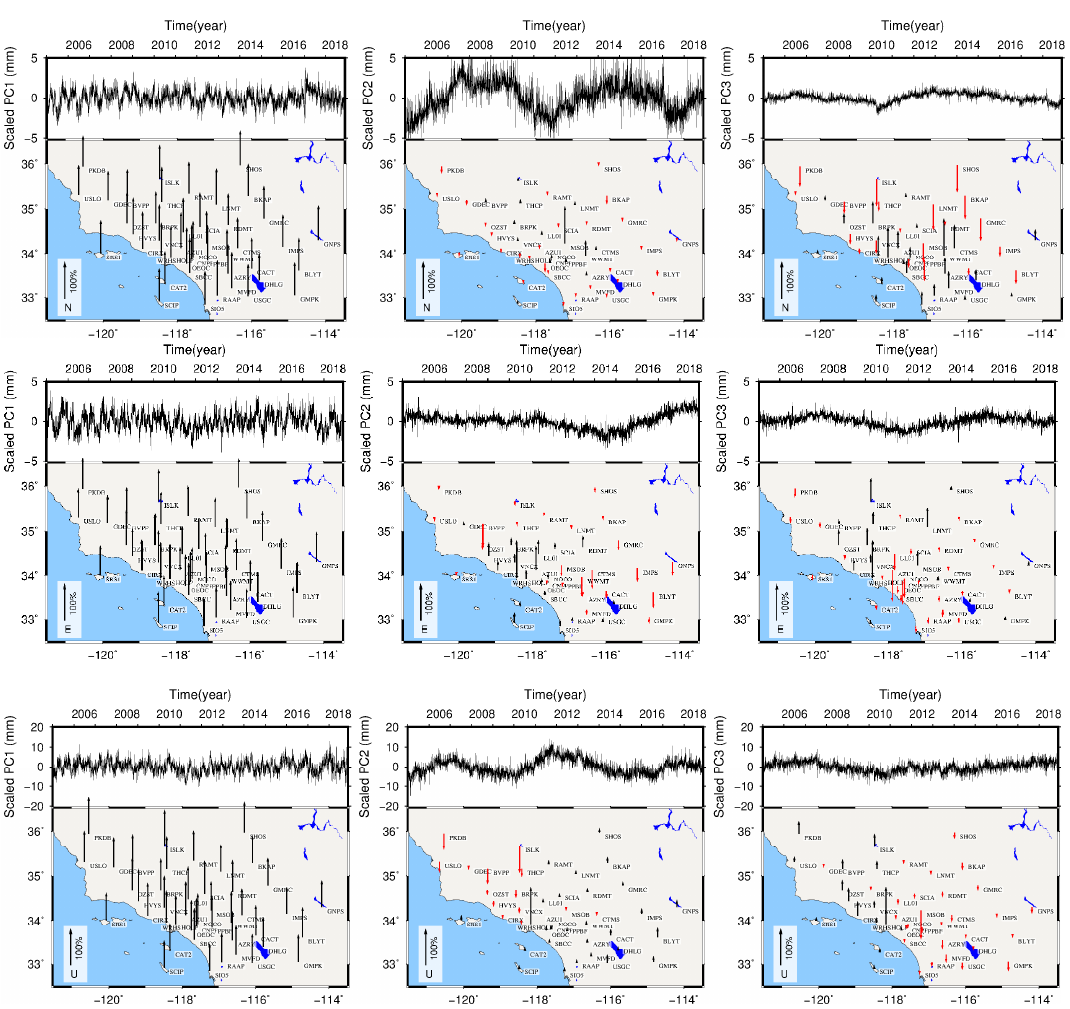
Figure 5. The first three scaled principal components (PCs: top) and their corresponding spatial responses (bottom) for the north (upper panels), east (middle panels), and up (lower panels) components of the 44 GNSS stations. The up-black and down-red arrows represent positive and negative responses to the scaled PCs, respectively.